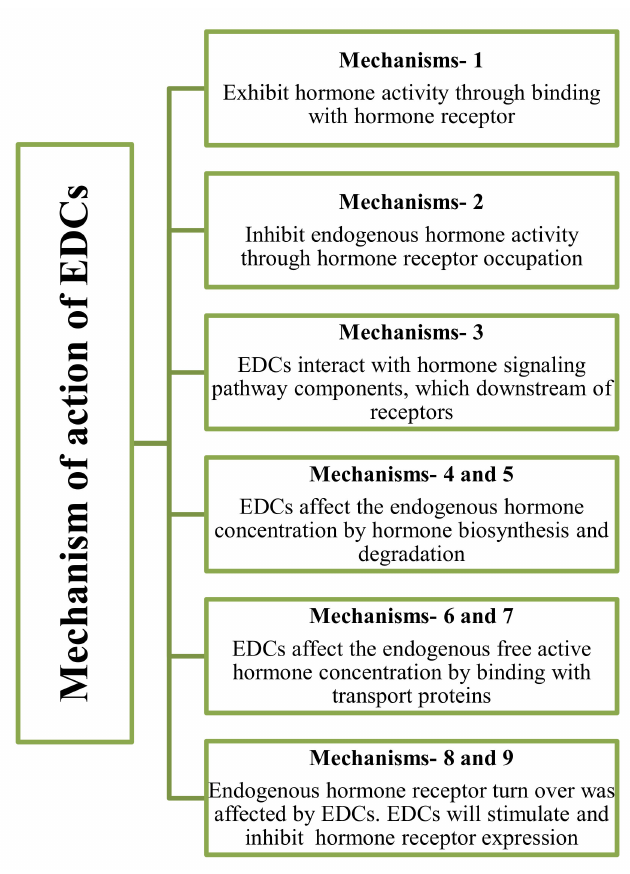
Figure 2. Mechanism of action of EDCs. Intracellular response was triggered by the binding of hormones to a receptor and tissue-specific properties of the target cell. EDCs could alter the signal transduction through membrane and intracellular hormone receptors. These two classes of receptors are: cell surface membrane receptors and nuclear steroid hormone receptors. Hormones are involved in development and differentiation by modifying the epigenetic process. These cascade actions were perturbed by EDCs. Important key enzyme expressions were also increased by pesticides such as methoxychlor